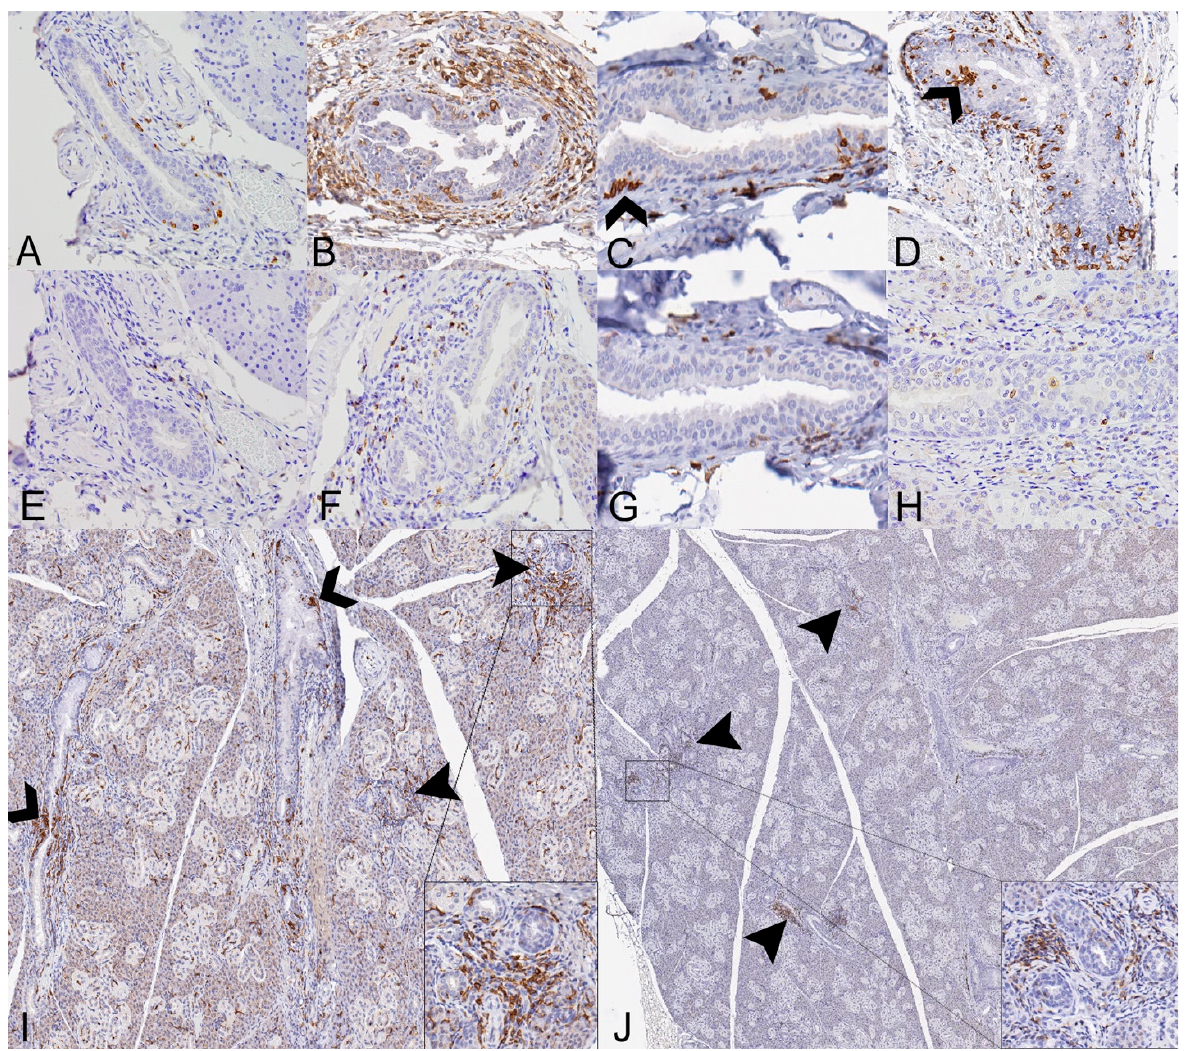
Figure 7. Distribution of Iba1- and CD3-immunolabeled cells in the salivary glands of SOSV-infected Egyptian rousette bats euthanized at 6, 9 and 21 DPI. ( A ) Iba1 immunohistochemistry (IHC), salivary gland, control bat 290195. Low numbers of Iba1+ cells (brown) are present within the salivary duct and surrounding connective tissue. Original magnification = 400 × ( B ) Iba1 IHC, salivary gland, 6 DPI bat 284899. Numerous Iba1+ cells morphologically consistent with macrophages or dendritic cells infiltrate the salivary gland duct epithelium and expand the adjacent